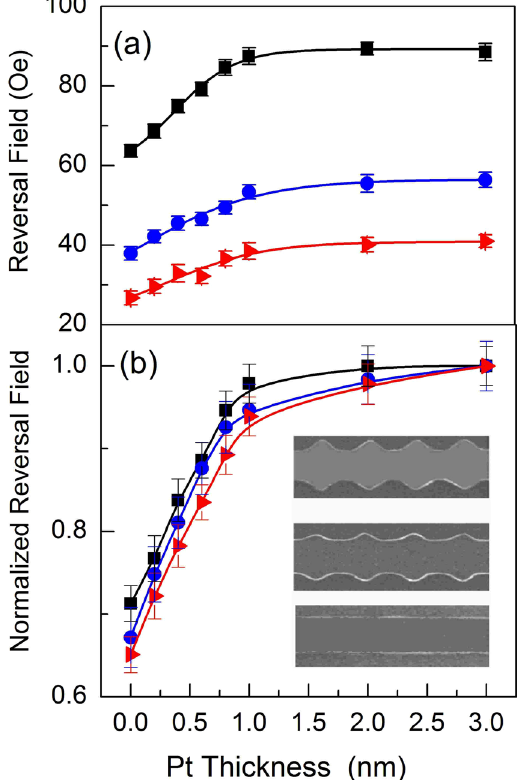
Figure 4. Reversal field as a function of Pt thickness. In ( a ), for different periodic edge-modulated nanowires the reversal field goes up rapidly from 0 nm to 1 nm Pt thickness, for thicker Pt the reversal field is roughly constant. In ( b ), the normalized reversal field shows that the behaviour as a function of Pt thickness is, indeed, independent of the nanowire geometry. Insert, Scanning electron microscopy (SEM) images of nanowires show the different geometries used to studied DW propagation in NiFe with a Pt overlayer. The triangles, dots and squares observed in ( a ) and ( b ) are related to parallel sided and periodic modulated 30 and 75 nm amplitude,